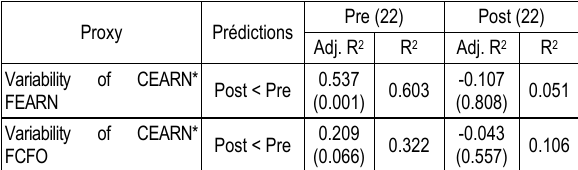
Table 3. Earnings and cash flow